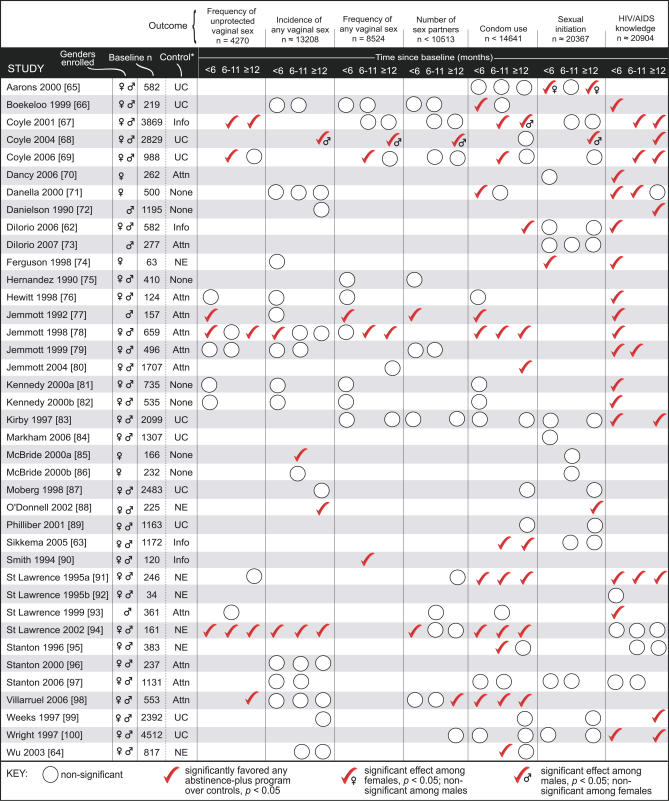
Trials Reporting Behavioural Outcomes and HIV/AIDS KnowledgeFor each outcome n refers to the total number of participants analyzed at any follow-up. Where no symbol appears, the outcome was either not measured or not reported. No harms were observed. All results were reanalyzed in RevMan software where possible, controlling for clustering. If two or more data points fell into the same follow-up range (e.g., 12 mo and 24 mo assessments), a significant effect at any follow-up is reported. If an outcome was measured more than one way (e.g., percentage of condom-protected intercourse occasions, condom use at last intercourse), a significant effect for any definition is reported.*Attn, attention-matched program that did not focus on HIV prevention; Info, information about HIV; NE, “nonenhanced” program version; None, no treatment; UC, usual care.